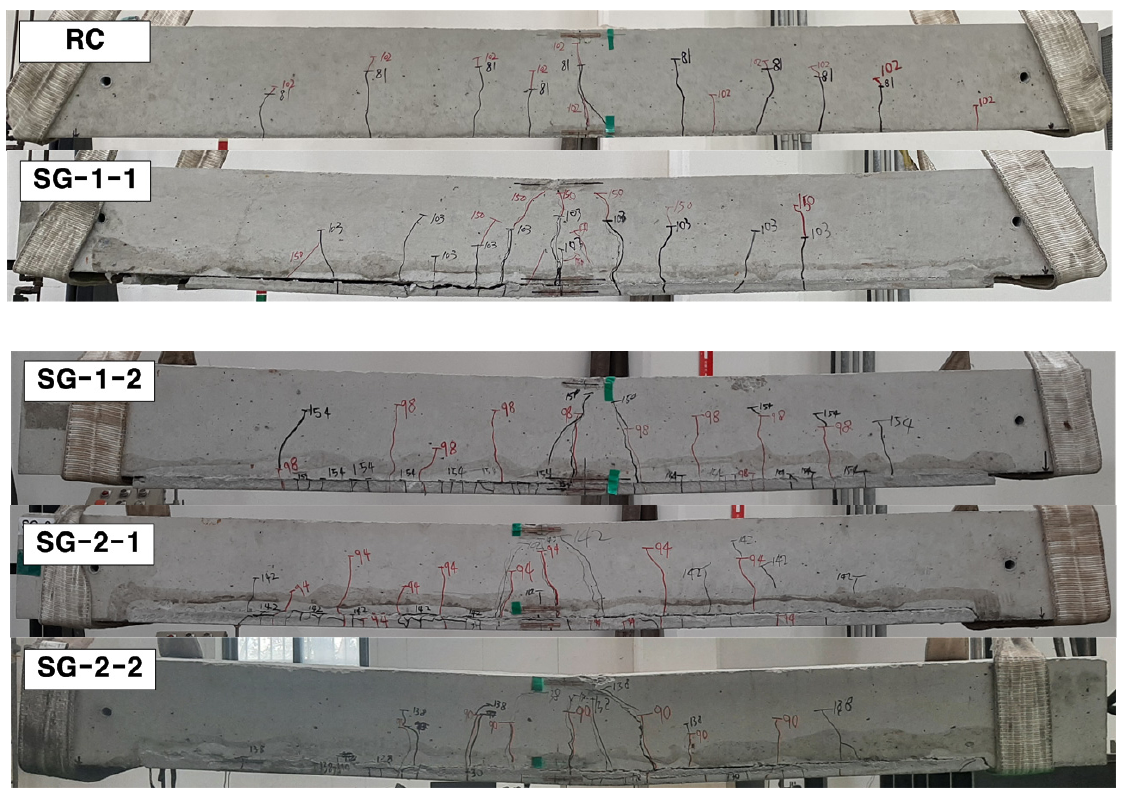
Figure 9. Crack patterns of specimens (side view).